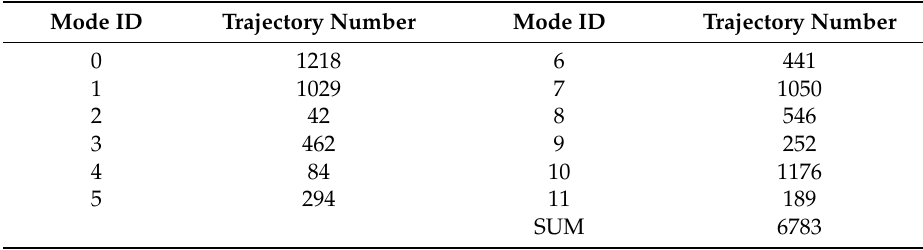
Table 4. The distribution of MDRT in this